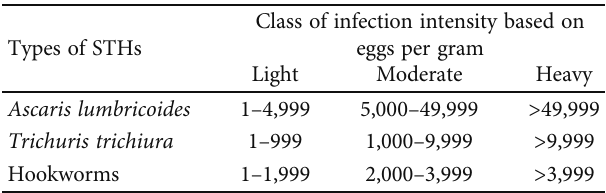
Table 1: Classi fi cation of soil-transmitted helminth (STH) infection intensity based on World Health Organization